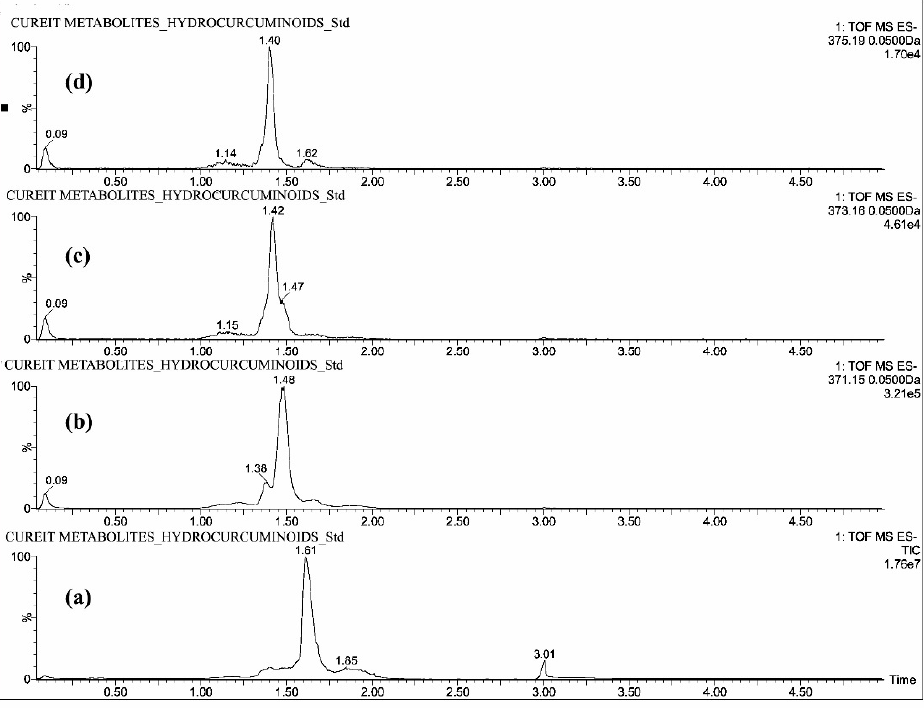
Figure 3. UPLC-QTOF-MS chromatograms of standards—( a ) total ion chromatogram of hydrogenated curcuminoids, extracted ion chromatograms of ( b ) THC, ( c ) HHC and ( d ) OHC.